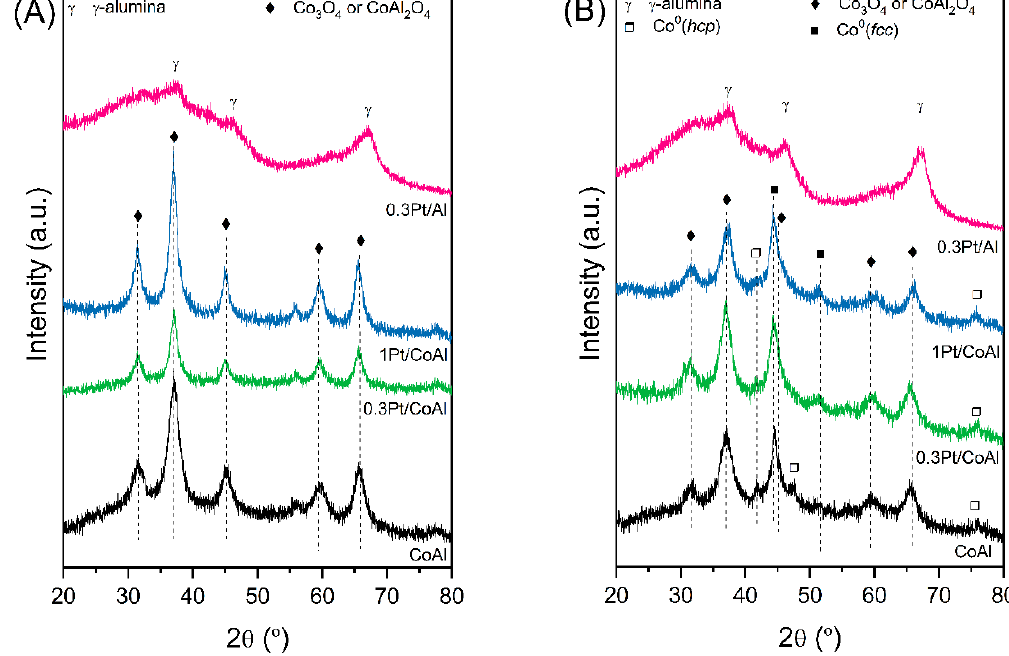
Figure 1. XRD patterns of ( A ) calcined and ( B ) reduced samples.